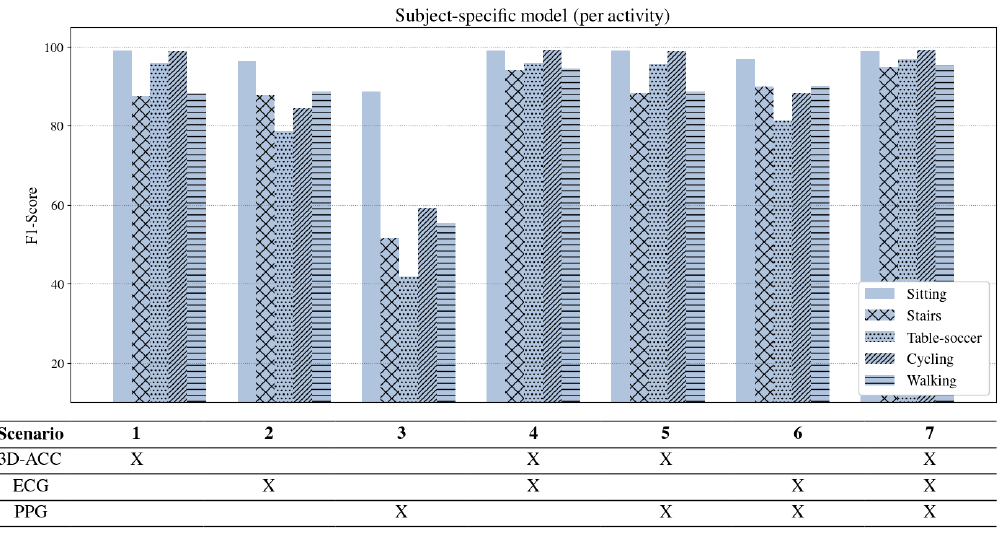
Figure 6. Subject-specific model results per